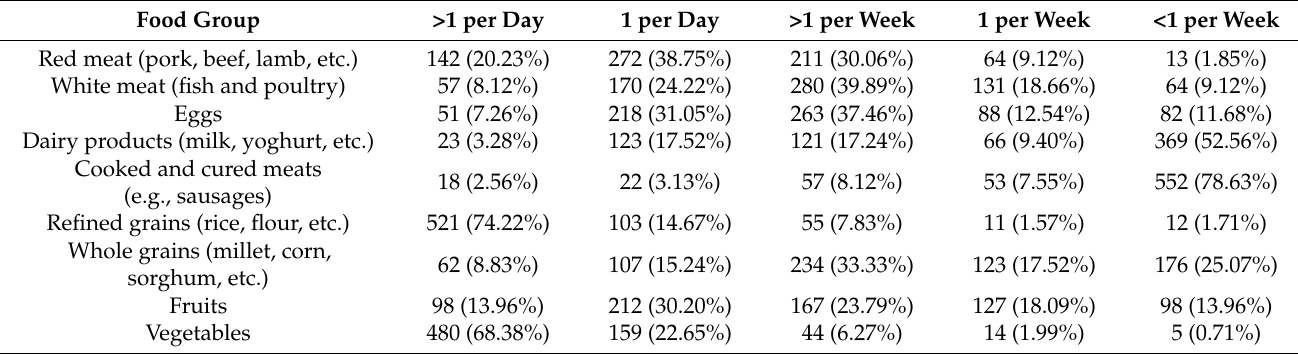
Table 2. Usual dietary consumption frequencies of the study